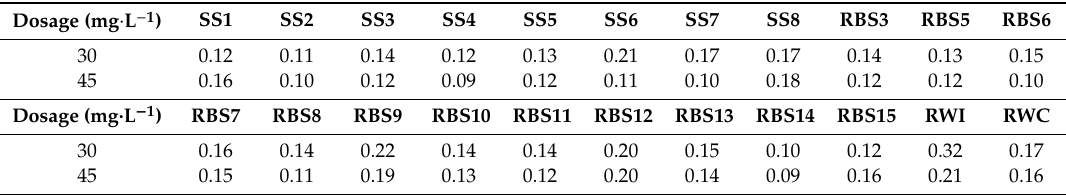
Table 2. Final turbidity (mean of duplicate tests) of raw water mixed with 22 sediments with two dosages of PACl (EC-309S), 30 mg · L − 1 and 45mg · L − 1 (initial turbidity = 70.00 NTU, pH = 7.47, temperature = 21 ◦